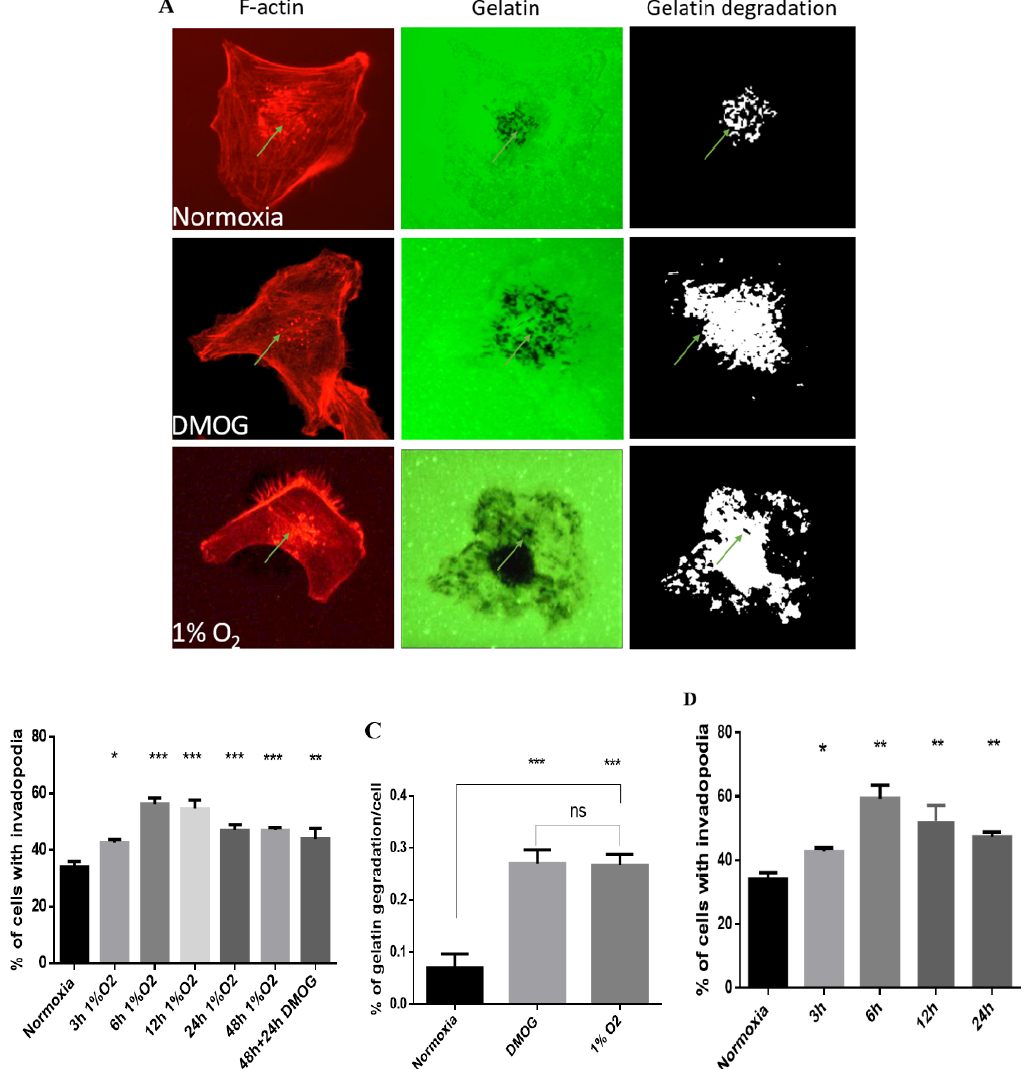
Figure 1. Hypoxia increases invadopodium formation and gelatin degradation in MDA-MB-231 cells. ( A ) Invadopodia-positive MDA-MB-231 cells stimulated with hypoxia by hypoxia chamber (1% O 2 ) and dimethyloxalylglycine (DMOG) treatment for 6 h, then seeded on gelatin-coated coverslips for 3 h, followed by fixing and staining for F-actin by rhodamine–phalloidin. Arrows, invadopodium formation. Gelatin degradation measured by ImageJ software; scale bar = 10 µ m. ( B ) Cells with invadopodia counted for presence of actin puncta that colocalized with gelatin degradation, quantified in time-dependent manner compared to in normoxia. ( C ) Quantification of gelatin degradation per cell in 3 di ff erent conditions. ( D ) Cells treated with DMOG alone for specific incubation time compared to normoxia; cells counted as in ( B ). Shown data, mean of 100 cells each from three independent experiments. Statistical significance analyzed using one-way ANOVA by GraphPad Prism 6; All data are the mean ± S.E.M of three independent experiments. * p < 0.05, ** p < 0.01 and *** p < 0.001, which is significantly di ff erent from other